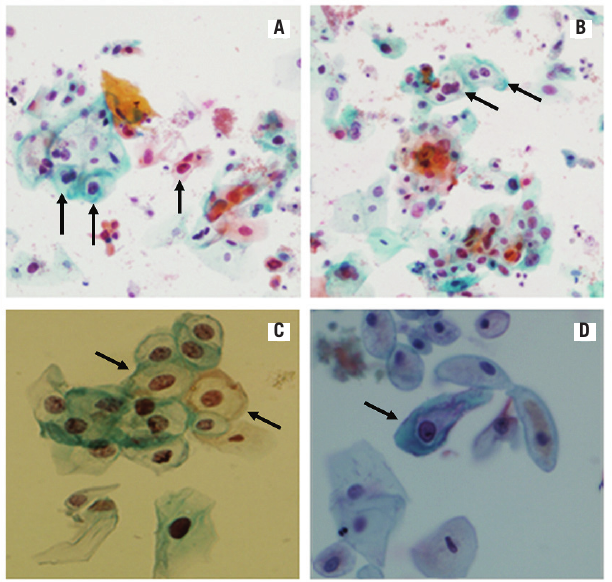
FigurE − Presence of koilocytes in UC. A and B: 20×; C and D: 40×, optical microscopy, Papanicolaou staining. Images by Leon, RM UC: urine cytology test.